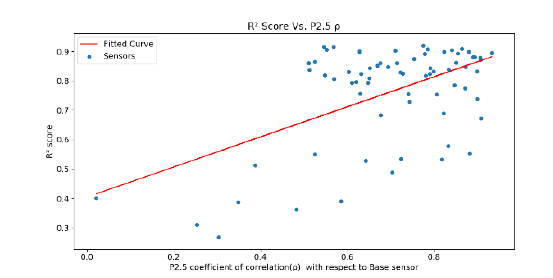
Figure 13. PM 2.5 Correlation and R 2 Score